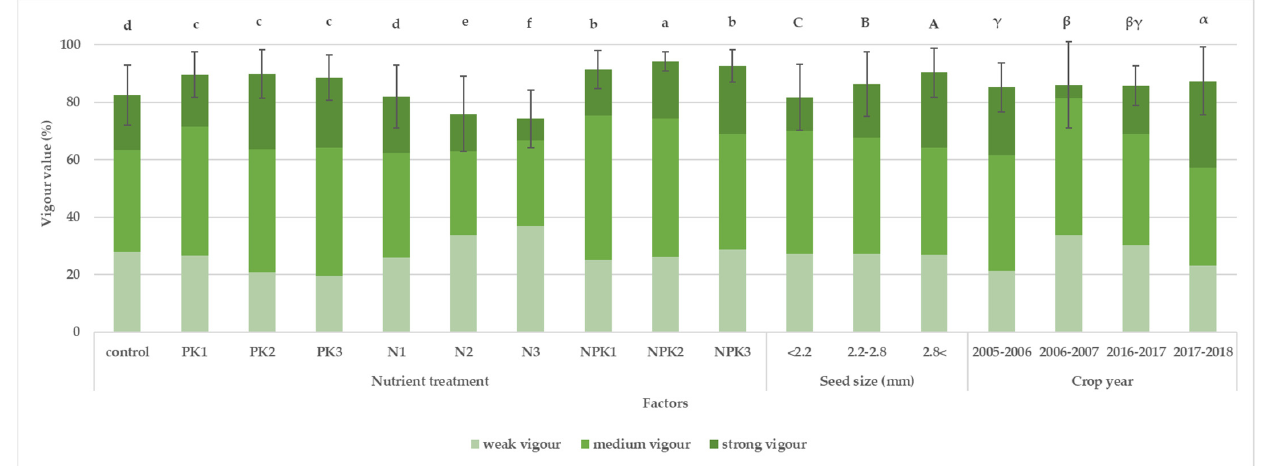
Figure 4. Effect of nutrient treatments, seed size and crop year on vigour value of winter wheat. (Values marked with different letters are significantly different at the p < 0.05 significance level. Small letters (a–f) represent nutrient treatments, capital letters (A–C) represent seed sizes and Greek letters ( α – γ ) represent years, where the order of the letters starts from the largest value. The standard deviation (SD) has been marked in the columns.)